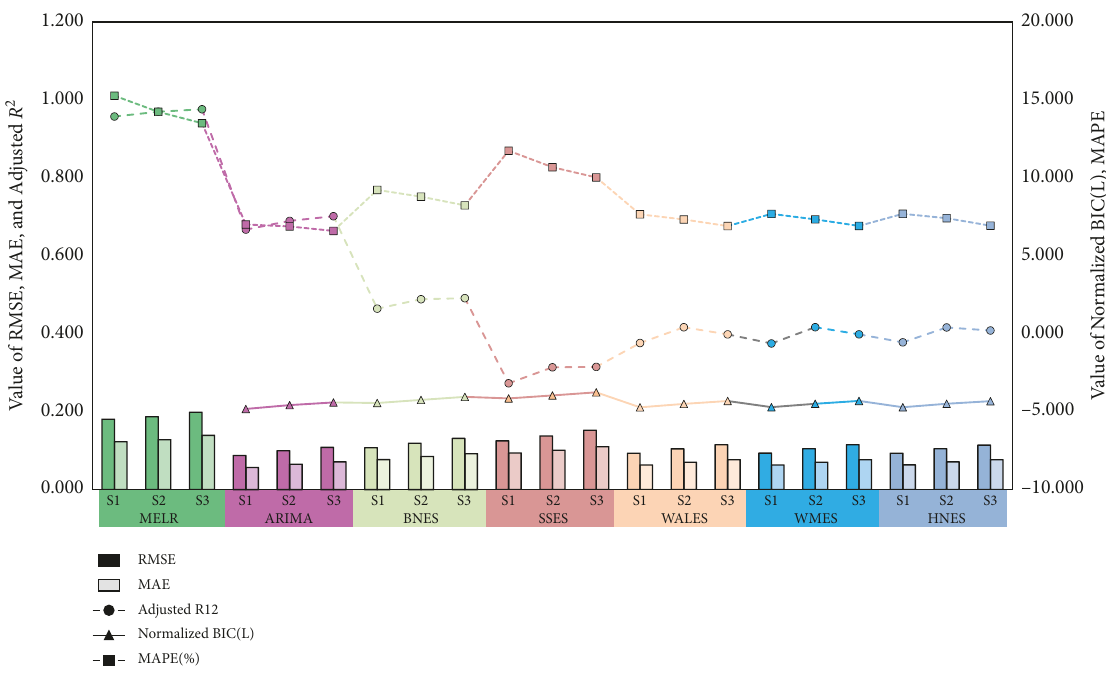
Figure 7: The comparison of key evaluation indices in MELR and time series models.